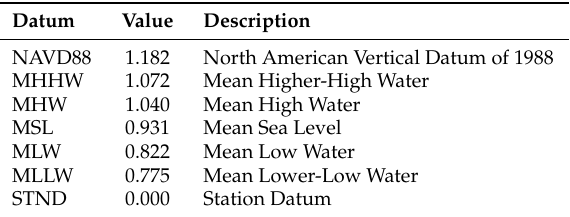
Table A1. Elevations on station datum in meters at Vaca Key, FL (NOAA station: 8723970). Tidal datum epoch: 1983–2001. Datum